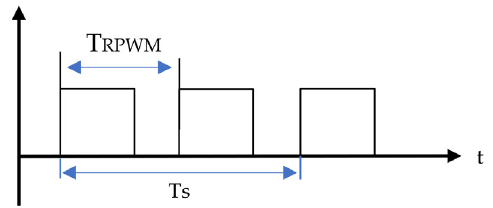
Figure A2. The RPWM signal.